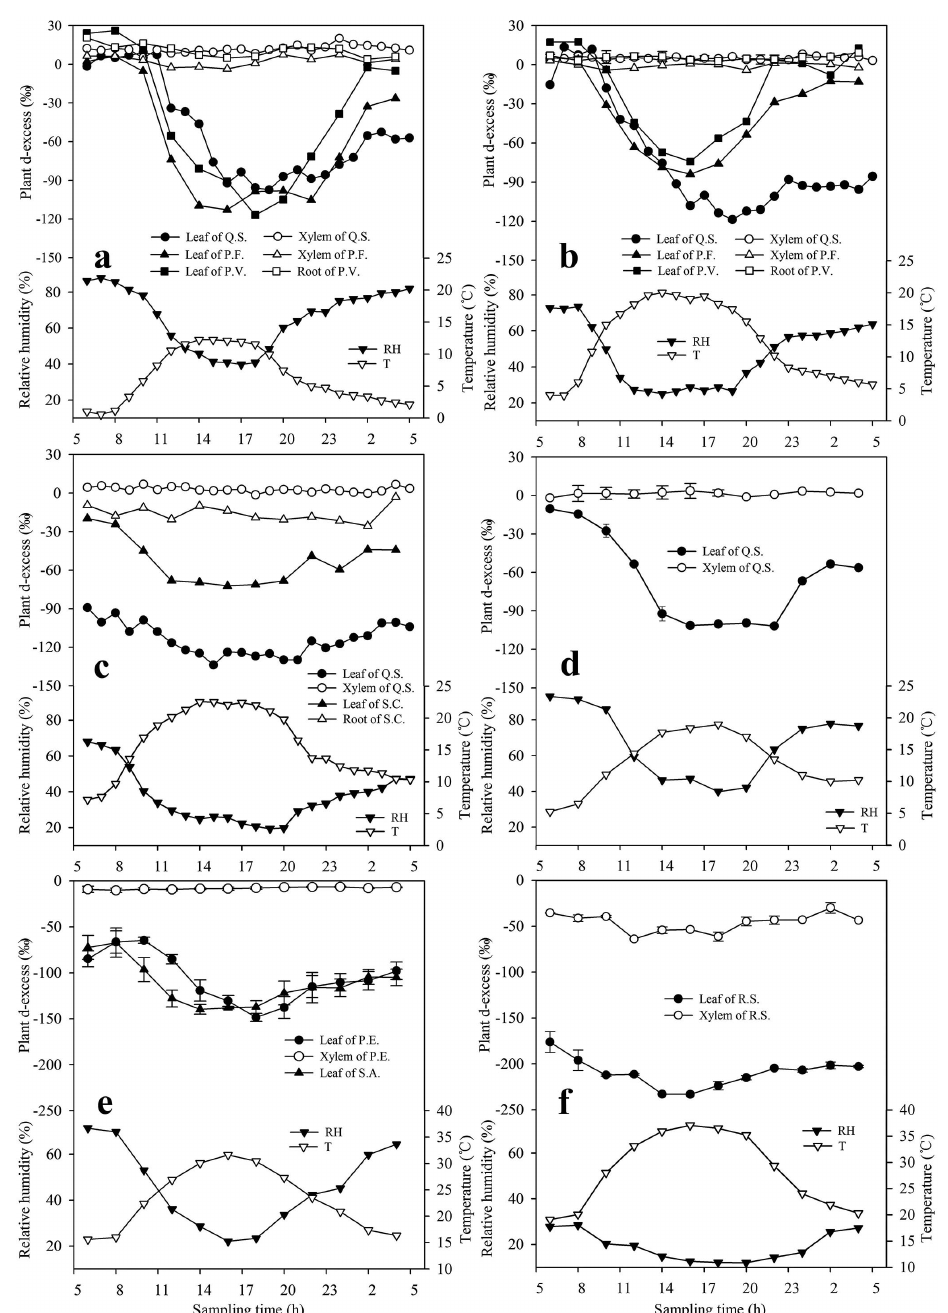
Figure 4. Variations in leaf and xylem water d-excess on the sunny days of the upper reaches and lower reaches of the Heihe River basin. Note: panels (a) , (b) , (c) , (d) , (e) and (f) refer to the same location as in Fig. 2, and the abbreviations of plant Latin names were the same as in Table 3. The following sunny days were selected: S1-Sep: from 06:00 to 18:00, 7 and 8 September; S1-Jun: from 06:00 to 16:00, 23 June; S2-Jun: from 06:00 to 16:00, 27 June; S3-Aug: from 06:00, 1 August to 16:00, 2 August and from 06:00 to 18:00, 3 August 2009. All data at S4-Aug and S5-Aug were